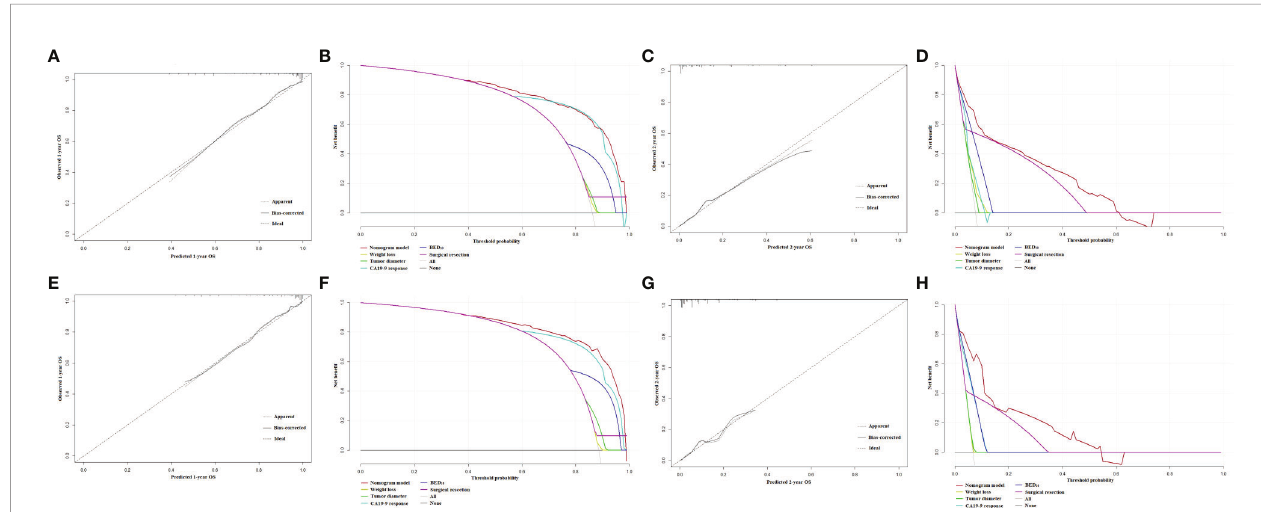
FIGURE 2 | (A) The calibration plot of OS at 1 year in the development cohort. (B) Net bene fi t in relation to threshold probability of OS at 1 year in the development cohort. (C) The calibration plot of OS at 2 years in the development cohort. (D) Net bene fi t in relation to threshold probability of OS at 2 years in the development cohort. (E) The calibration plot of OS at 1 year in the validation cohort. (F) Net bene fi t in relation to threshold probability of OS at 1 year in the validation cohort. (G) The calibration plot of OS at 2 years in the validation cohort. (H) Net bene fi t in relation to threshold probability of OS at 2 years in the validation